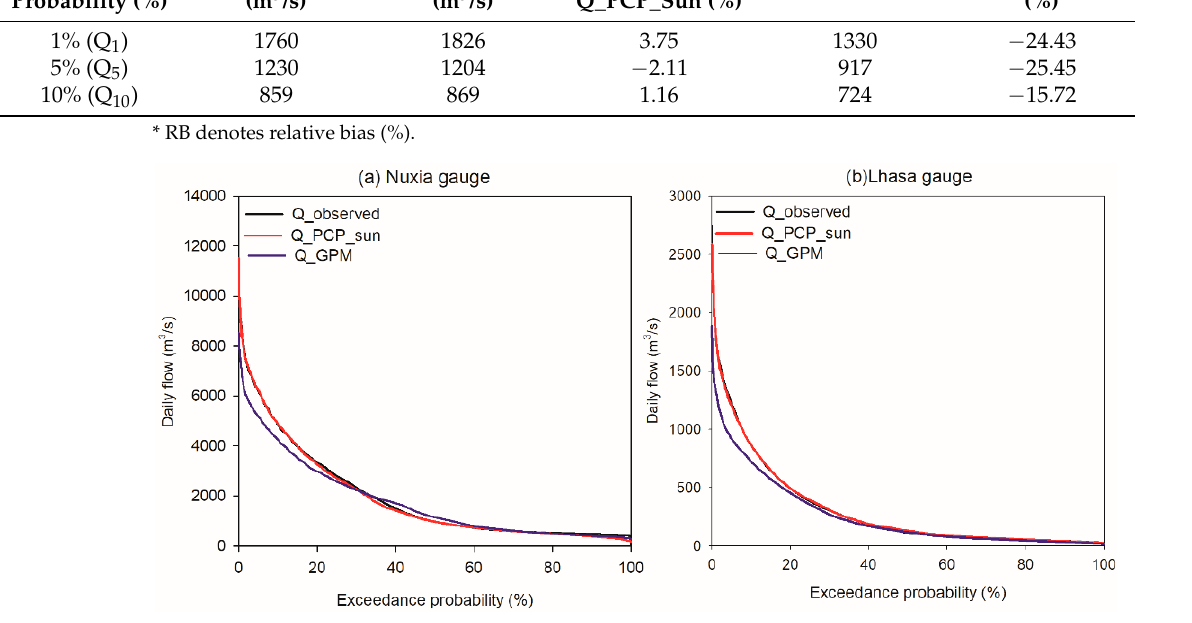
Figure 13. Flow duration curves of the observed and simulated daily discharge at ( a ) Nuxia and ( b ) Lhasa hydrological stations.